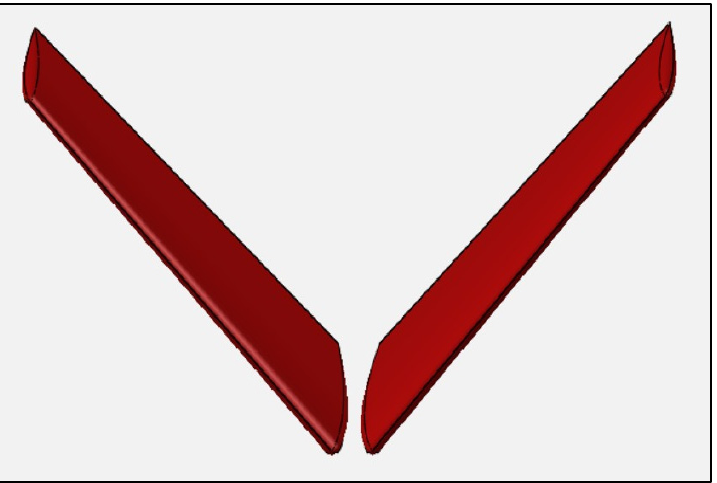
Figure 1. V-tail 3D model (modelled in OpenVSP with NACA 0010 as the